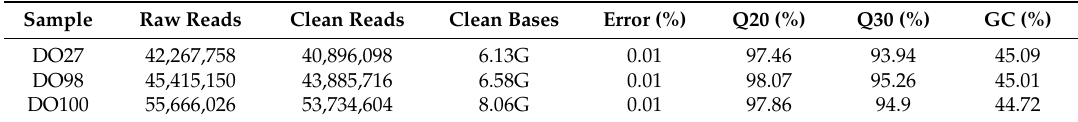
Table 2. Summary of D. odorifera base